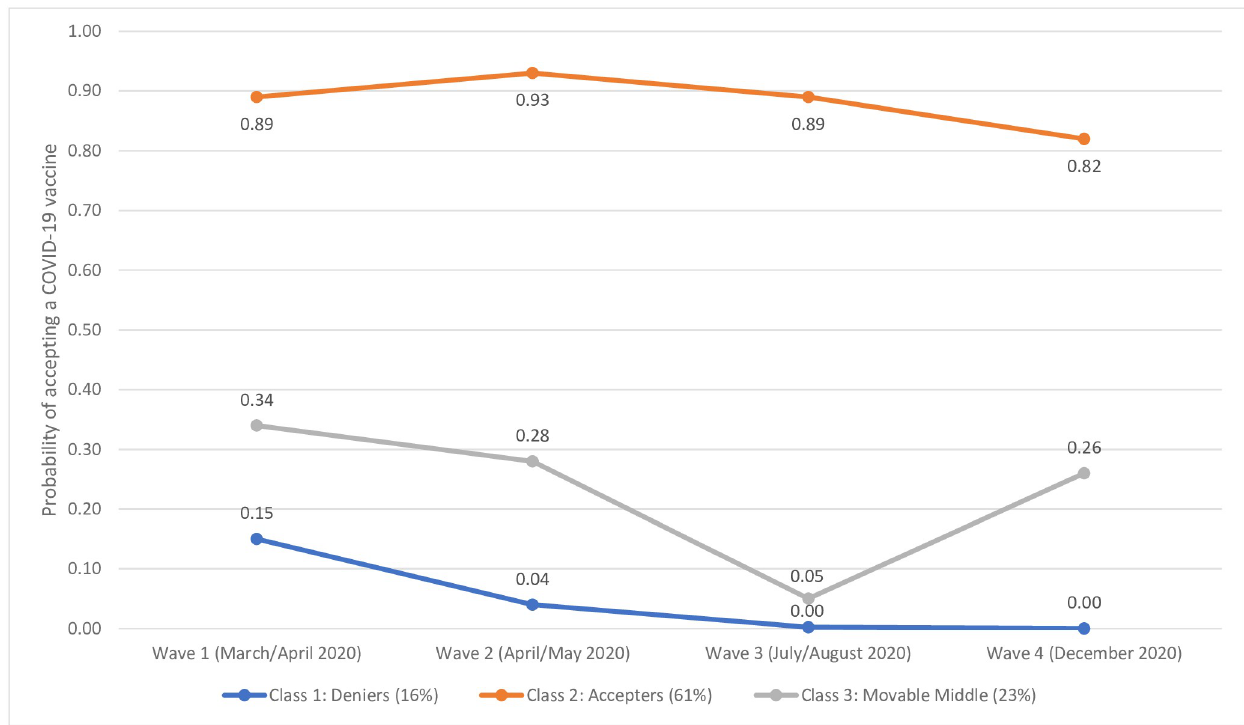
Fig 2. Latent class probabilities of COVID-19 vaccine acceptance in the Irish sample. Data are presented as the latent class probabilities of COVID-19 acceptance in the Irish sample (n = 1030) across four waves of data collection.